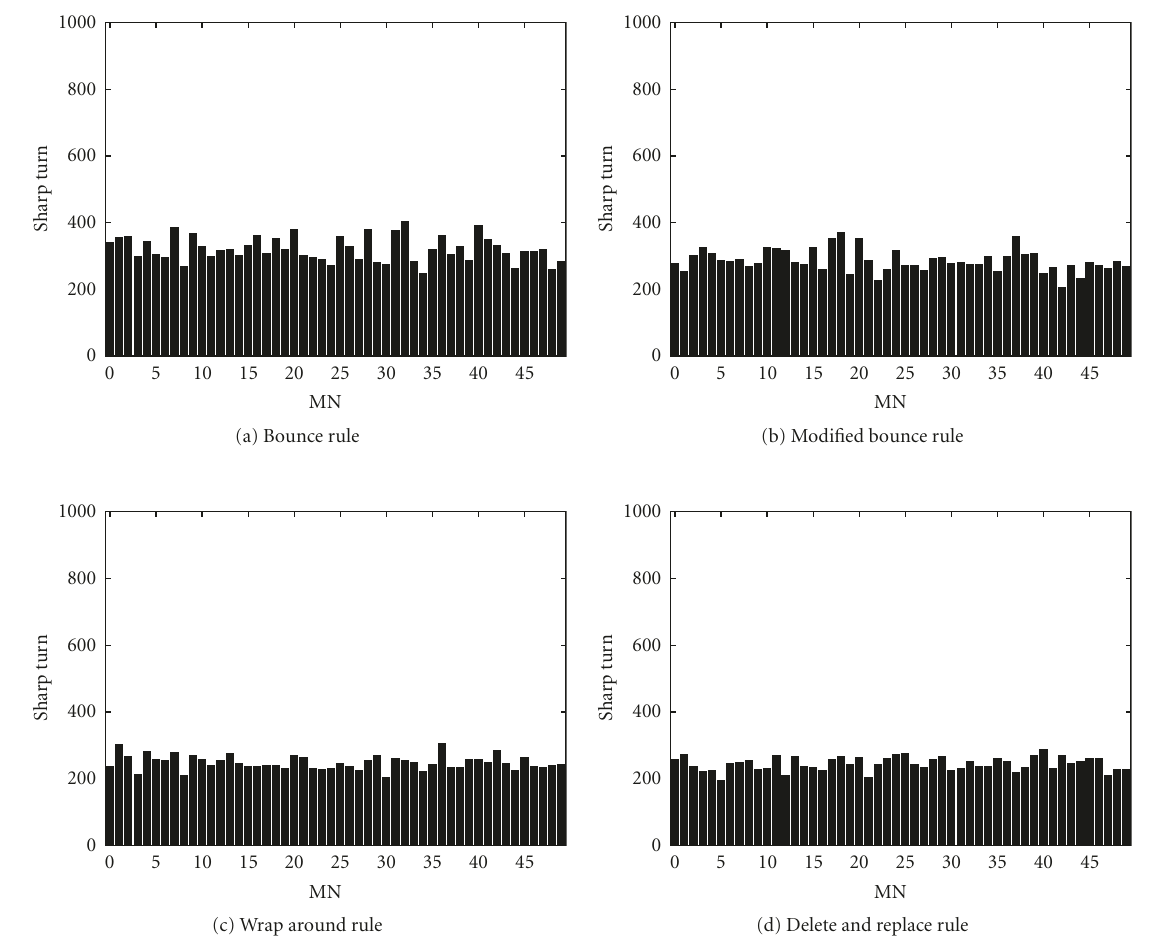
Figure 12: Number of sharp turns with the direction angle change (cid:2) 90 ◦ in the GIMM model with several border rules.